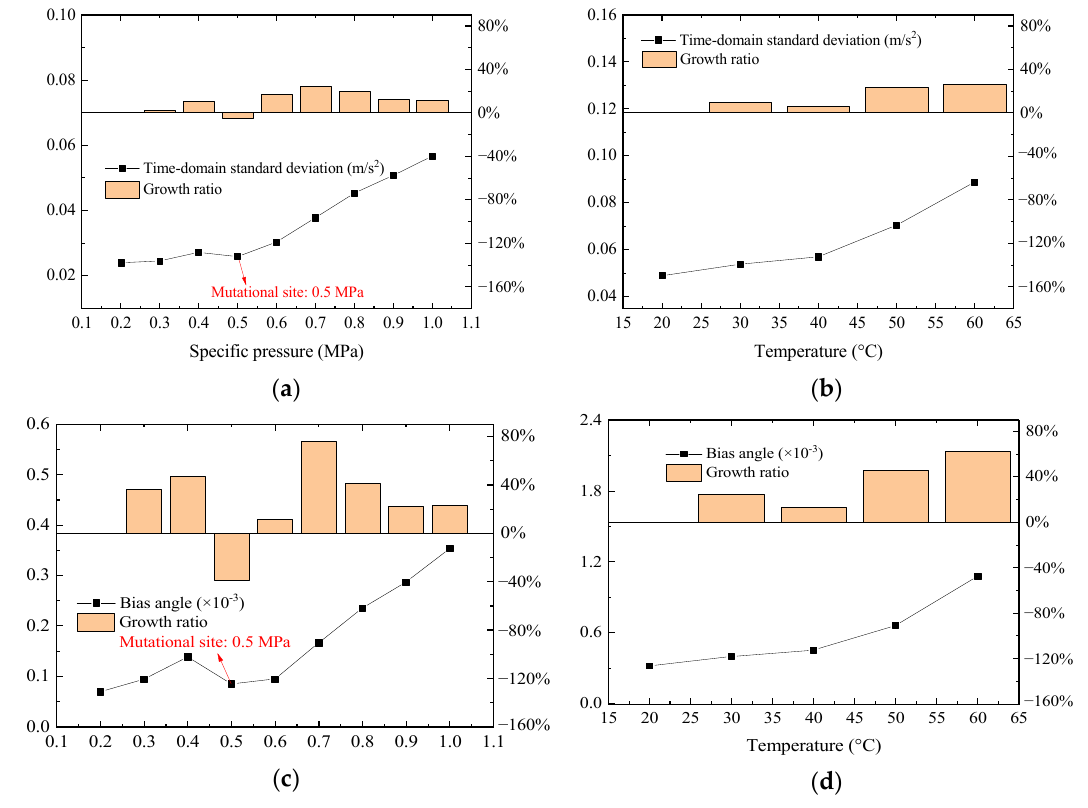
Figure 19. Effect of specific pressure and temperature on the time-domain standard deviation, bias angle and growth ratio. ( a ) Specific pressure, ( b )temperature, ( c ) specific pressure, ( d )temperature.